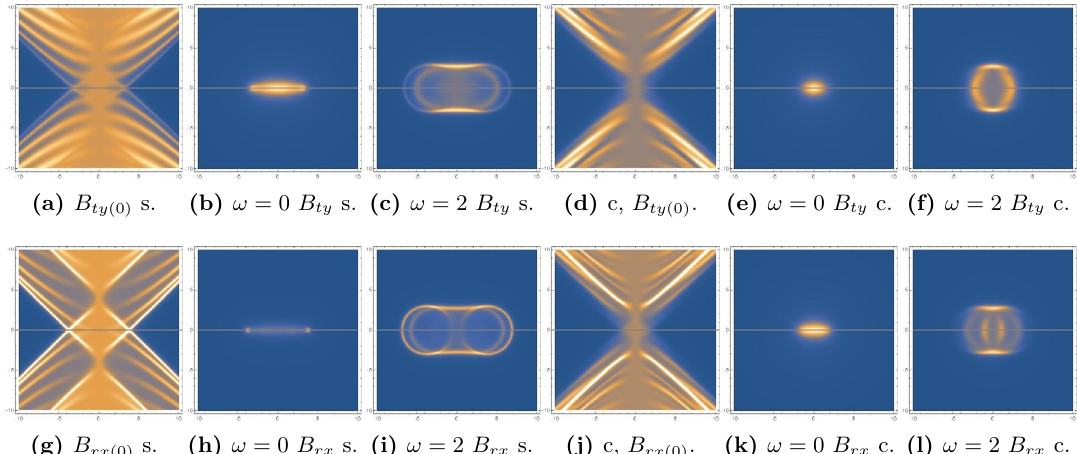
Figure 12. Spectrum of B rx and B ty with sliced views k x - k y at ω = 0 , 2 slices, without which these spectra are ambiguous. Notice the zero modes and Ribbons connecting the two split